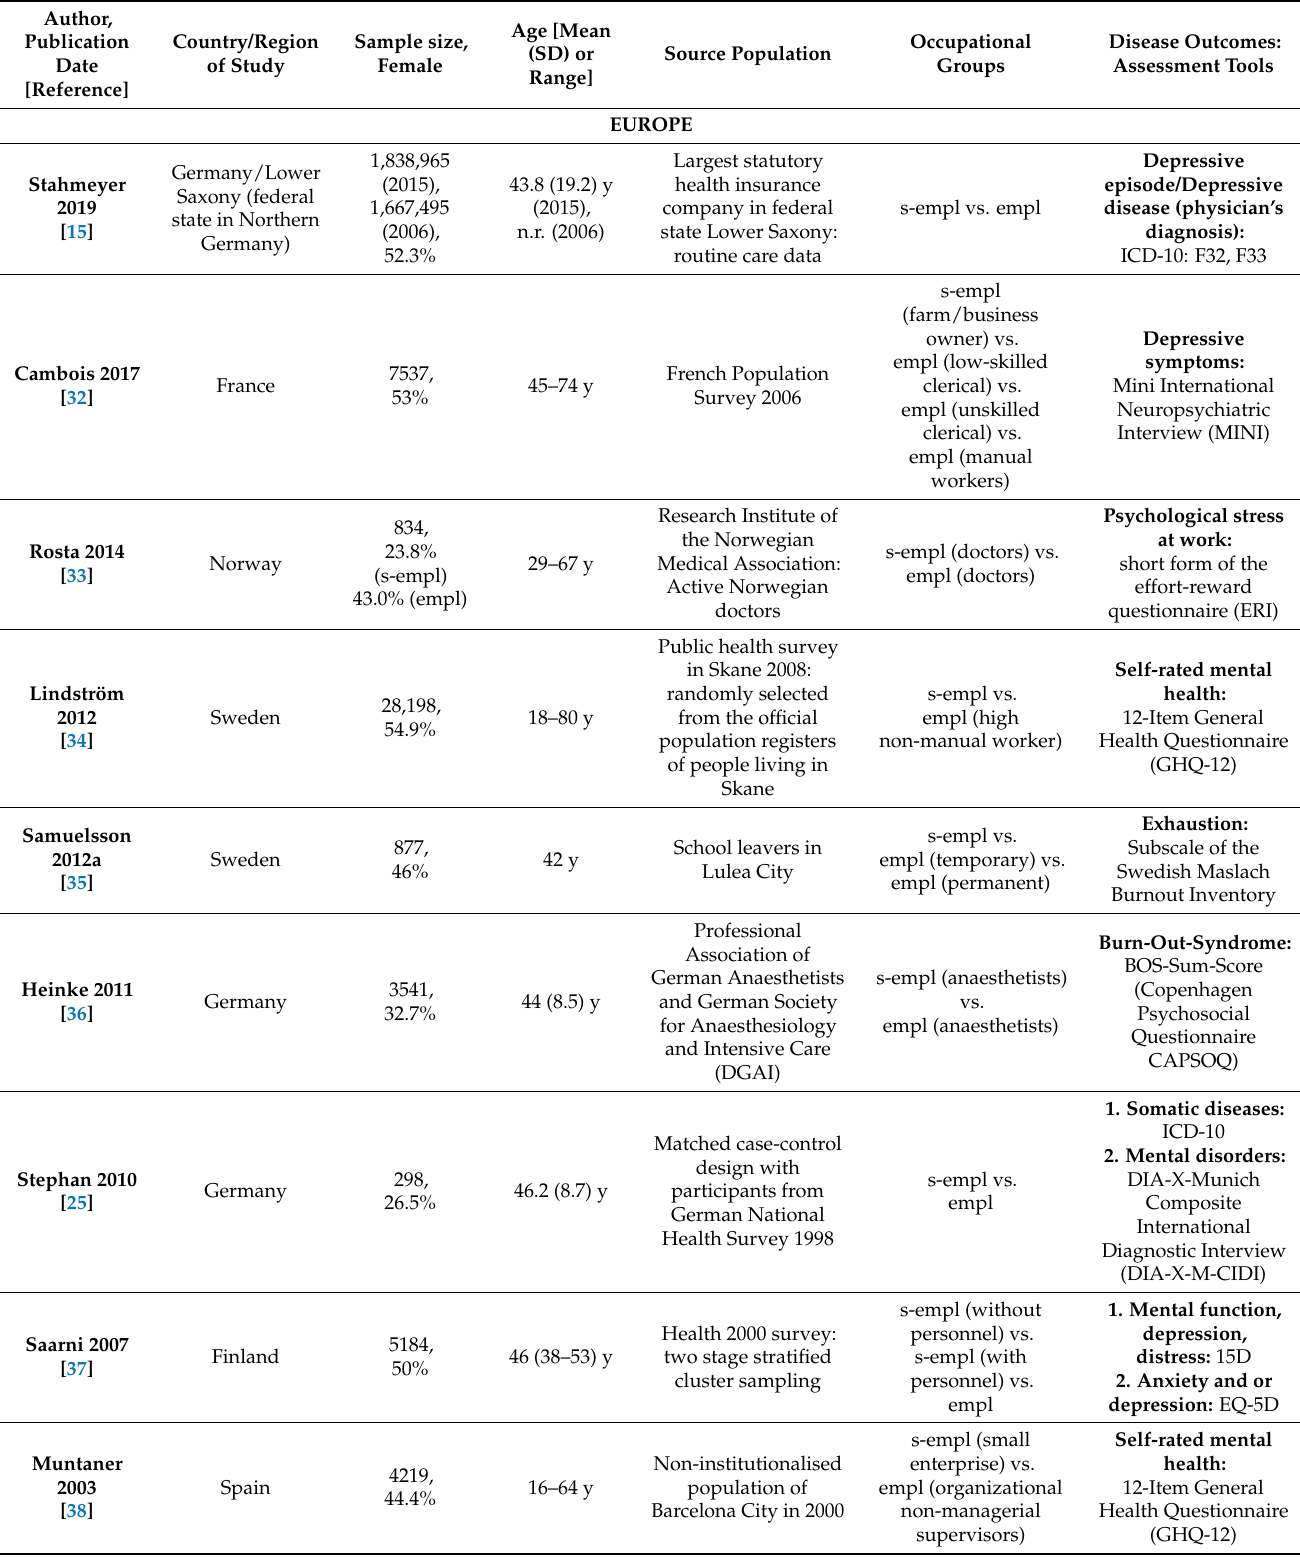
Table 3. Basic characteristics of cross-sectional studies of good quality on mental disorders comparing self-employed (s-empl) vs. employees